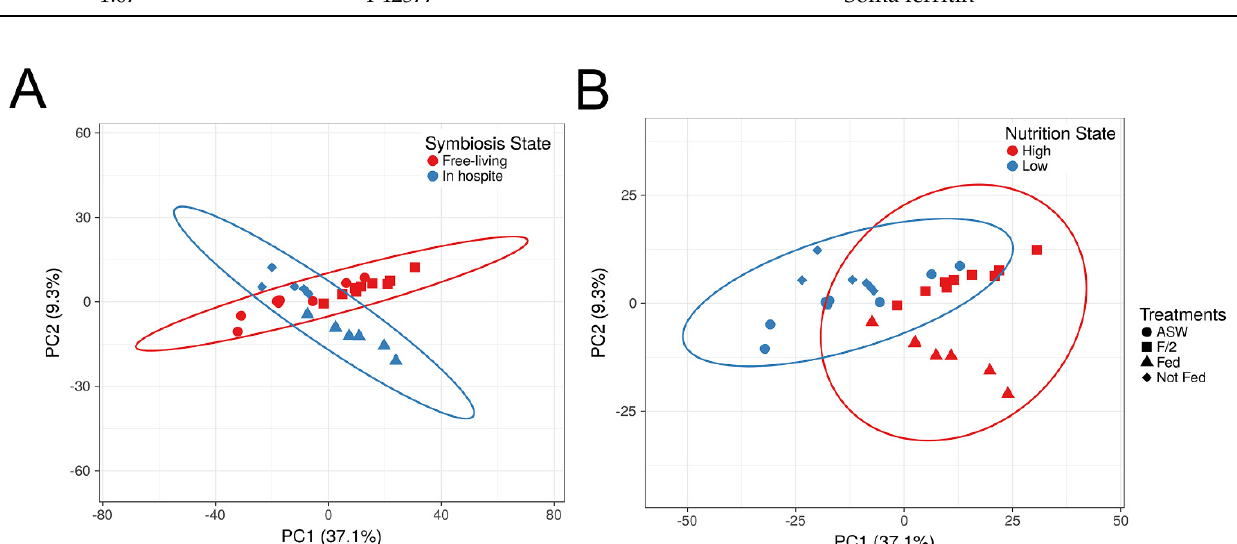
Figure 2. Principal component analysis of all detected Breviolum minutum proteins. ( A ) Contrasting algae in hospite with the sea anemone Aiptasia versus free-living cells; ( B ) high (i.e., well-fed in hospite or cultured in replete f/2 medium) versus low nutritional regimes, meaning starved in hospite or cultured in artificial seawater (ASW). Ellipses represent 99% confidence intervals.